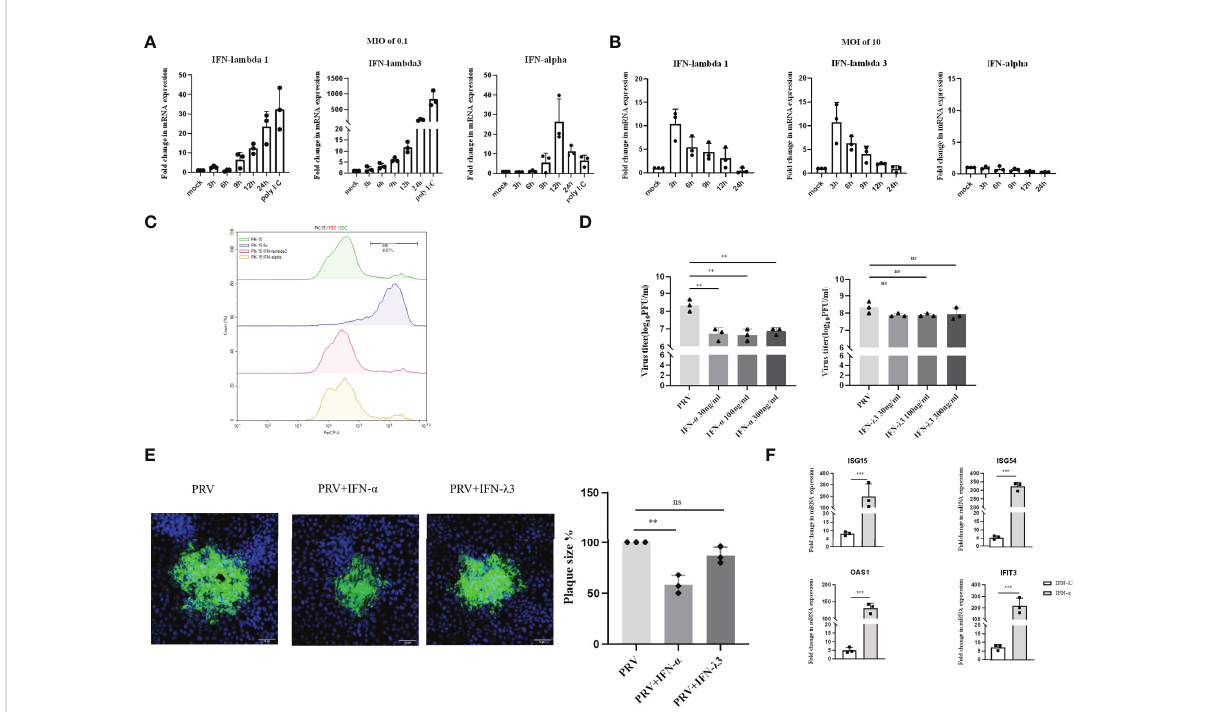
FIGURE 1 Expression and antiviral effect of type I and type III IFNs in response to PRV infection in PK-15 cells. PK-15 cells were inoculated with (A) low dose PRV (MOI of 0.1PFU/cell) or (B) high dose PRV (MOI of 10PFU/cell). At different time points post inoculation, cell lysates were prepared for RT-qPCR analysis of expression of porcine IFN- a , IFN- l 1 and IFN- l 3. (C) PK-15 cells were treated with IFN- a or IFN- l 3 (300ng/ml) for 24 h, followed by PI staining and fl ow cytometric analysis to assess cell viability. (D) PK-15 cells were pretreated with recombinant porcine IFN- a or IFN- l 3 (30, 100, 300ng/ml) for 24 h prior, followed by PRV inoculation (MOI of 0.1PFU/cell). At 24hpi, cell culture supernatants were collected and viral titers were determined. (E) PK-15 cells were pretreated with recombinant porcine IFN- a or IFN- l 3 (300ng/ml) for 24 h, followed by PRV inoculation. At 2hpi, medium was replaced with a semisolid medium to prevent cell-free spread of PRV particles. Plaque sizes were determined by immuno fl uorescence at 24hpi. (F) PK-15 cells were treated with recombinant porcine IFN- a (grey bars) or IFN- l 3 (black bars) (each at 300ng/ml) for 24 h followed by RT-qPCR analysis of the expression of different ISGs (ISG15, ISG54, OAS, IFIT3). Asterisks indicate statistically signi fi cant differences (ns: non-signi fi cant, **p < 0.01, ***p <